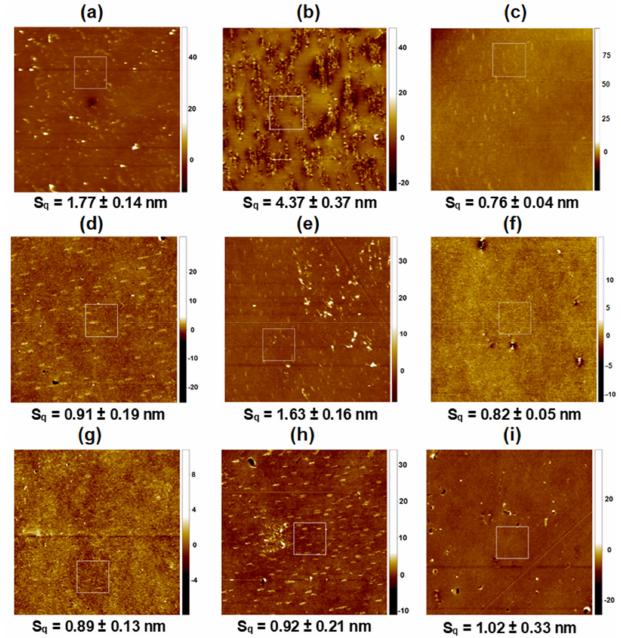
Figure 3. AFM micrographs for 20 µ m × 20 µ m scanned areas: PET ( a ), PET air ( b ), PET air /LG ( c ), PET air /DOPC ( d ), PET air /CsA ( e ), PET air /DOPC-CsA 0.50 ( f ), PET air /DOPC-CsA-LG 0.25 ( g ), PET air /DOPC-CsA-LG 0.50 ( h ), PET air /DOPC-CsA-LG 0.75 ( i ). Z scale: